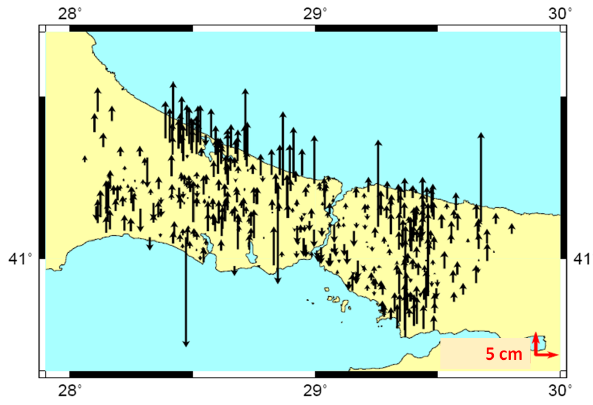
Fig. 6. Vertical displacements of stations, estimated relative to the ANKR station (created using the GMT software) using GPS obser- vations conducted within the IGNA network in 1999 and 2005.